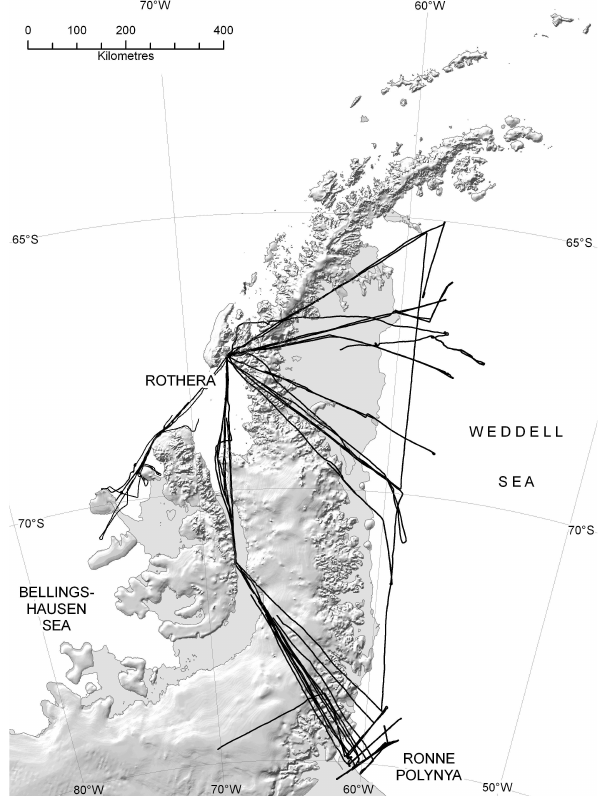
Fig. 1. Map of Antarctic Peninsula with flight tracks (black lines) flown during the aircraft field campaigns 2007 and 2008, which form the basis of this